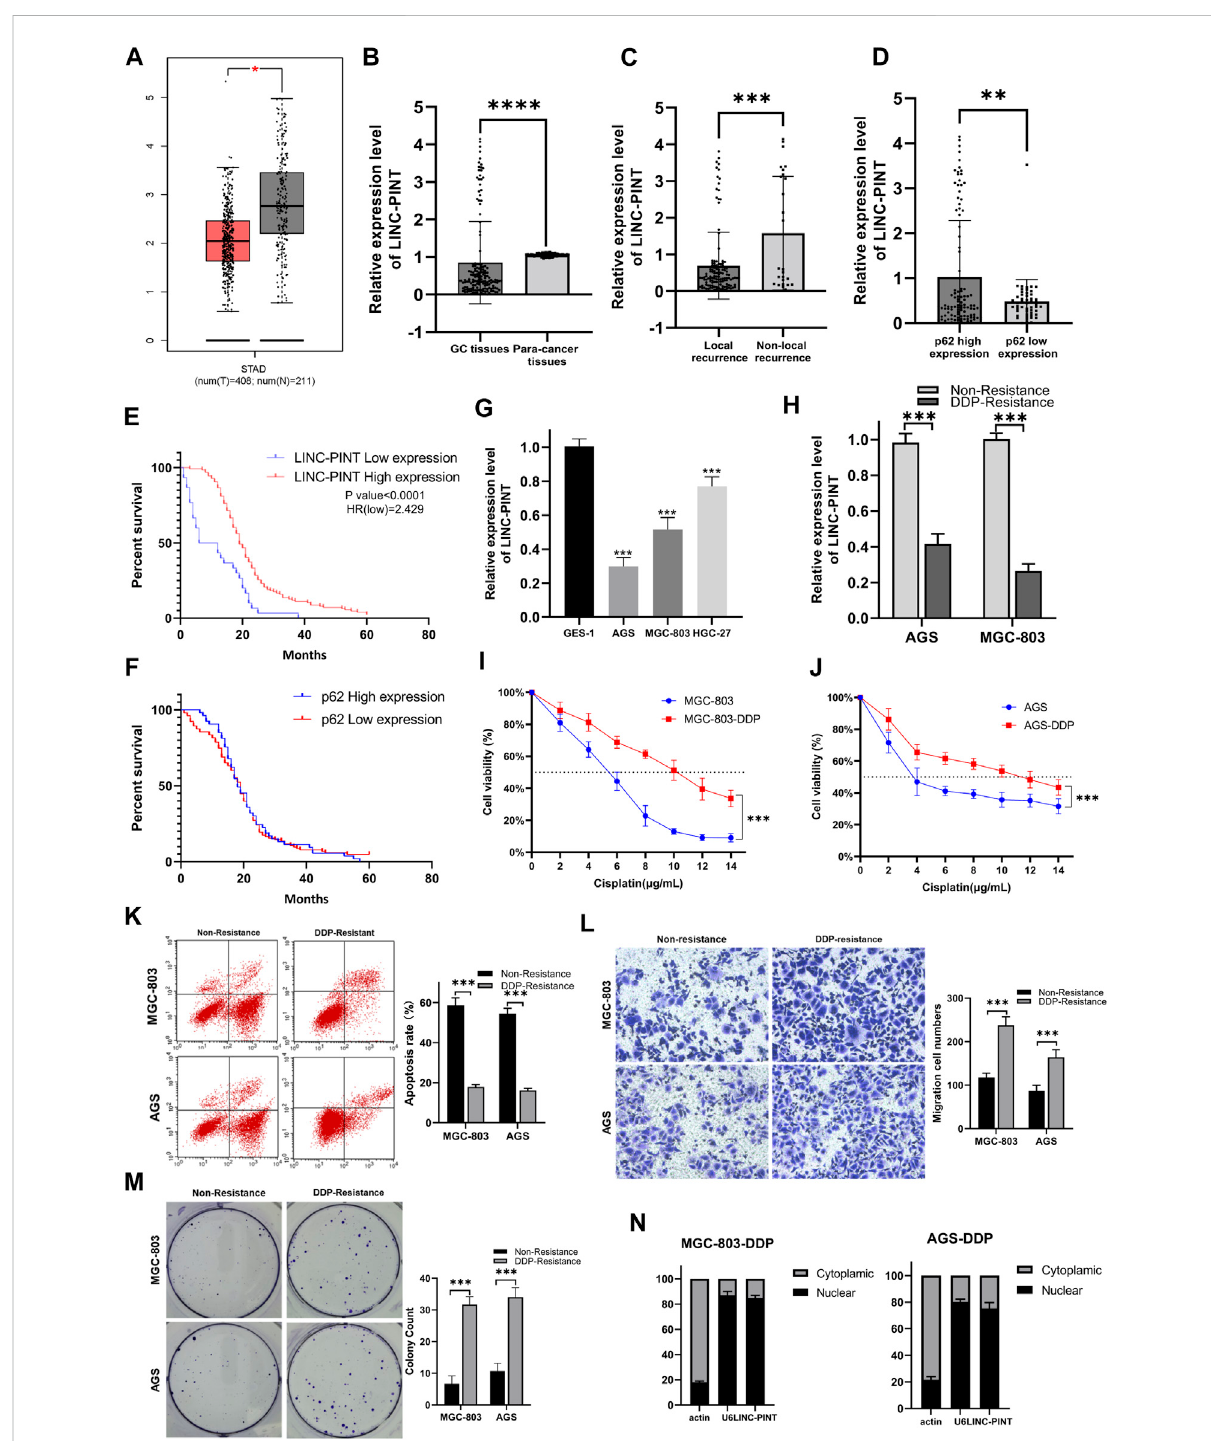
FIGURE 1 (A) The expression of LINC-PINT in gastric cancer tissues versus adjacent normal tissues based on the GEPIA database (Gene Expression Pro fi lingInteractiveAnalysisdatabase;gepia.cancer-pku.cn). (B) TheexpressionofLINC-PINTin156pairedgastriccancertissuesandparacancerous tissues. (C) The expression of LINC-PINT in local recurrence gastric cancer tissues and non-local recurrence paracancerous tissues. (D) LINC-PINT expression in gastric cancer tissues with high expression of p62 and low expression of p62. (E) Kaplan – Meier analysis for overall survival of patientswithlowandhighexpressionofLINC-PINT. (F) Kaplan – Meieranalysisforoverallsurvivalofpatientswithlowandhighexpressionofp62. (G) LINC-PINT expression in GC cell lines and normal gastric cell lines. (H) LINC-PINT expression in DDP-resistant GC cell lines and non-resistant cell lines. (I) CCK-8 assay in MGC-803 and MGC-803-DDP evaluating the IC50 of DDP. (J) CCK-8 assay for AGS and AGS-DDP evaluating the IC50 of DDP. (K) FlowcytometryevaluatingtheapoptosisofDDP-resistantandnon-resistantGCcells. (L) Transwellassaysevaluatingthemigrationabilityof DDP-resistant and non-resistant GC cells. (M) Colony formation assay of DDP-resistant and non-resistant GC cells. (N) Subcellular localization of LINC-PINTinAGS-DDPandMGC-803-DDPcelllines.Dataarerepresentedasthemean±SD.* p < 0.05.** p < 0.005.*** p < 0.001.Theexperiments were repeated independently at least three